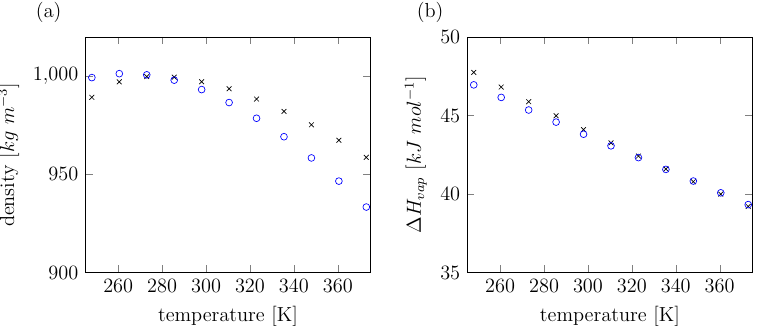
Figure 6: Density ( ρ ) and heat of vaporization (∆ H vap ) over a range of temperatures (248 K – 373 K) for water: comparison between experimental values (black crosses) and values calculated from simulation using the water model presented in this work (blue circles). Calculated values of ∆ H vap are corrected for changes in vibrational modes upon evaporization, which contribute significantly as documented by Horn et al. 14